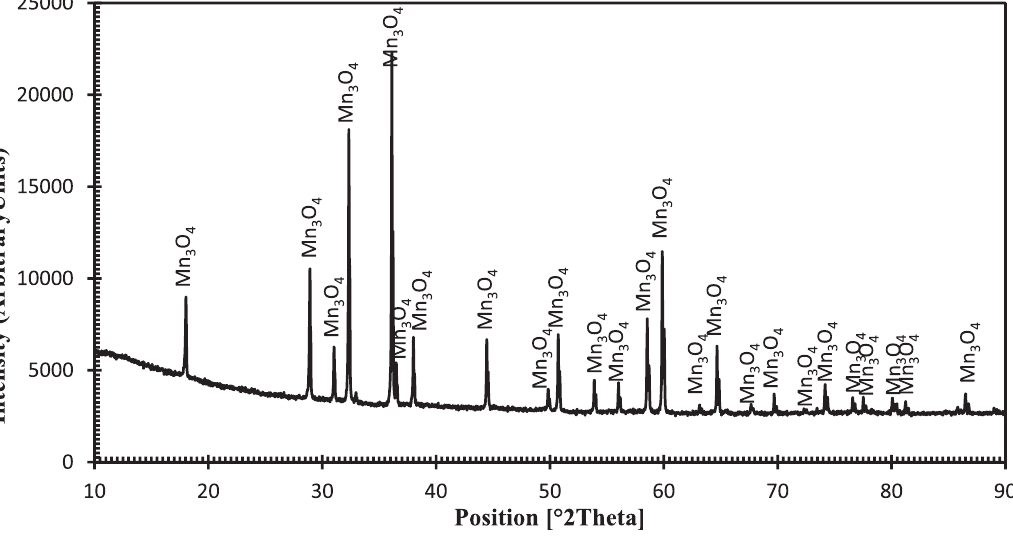
Fig. 5: XRD patterns of Mn 3 O 4 before